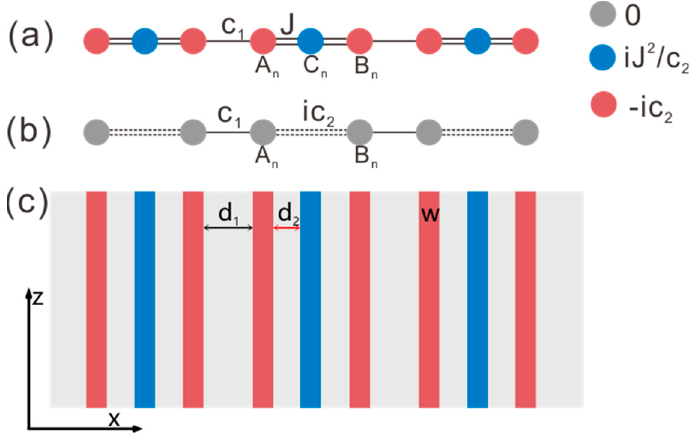
Figure 1. The geometry of the proposed Su–Schrieffer–Heeger (SSH) chain. ( a ) The suggested chain with assistant lattice. ( b ) The effective chain after adiabatic elimination. ( c ) The geometry of proposed planar waveguide.